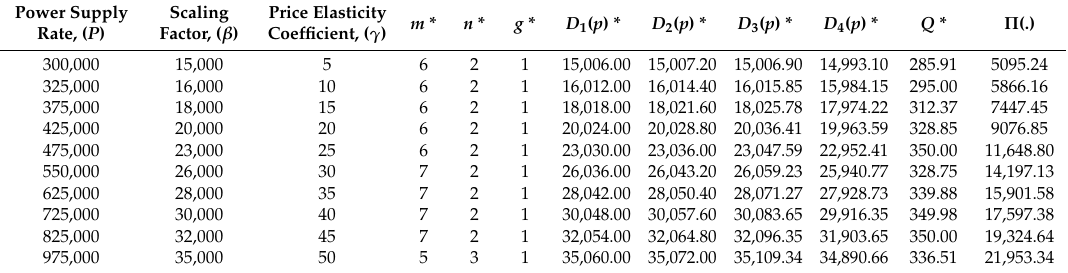
Table 11. Effect of Changes on Power Supply Rate, Scaling Factor, and Price Elasticity Coefficient Parameters.